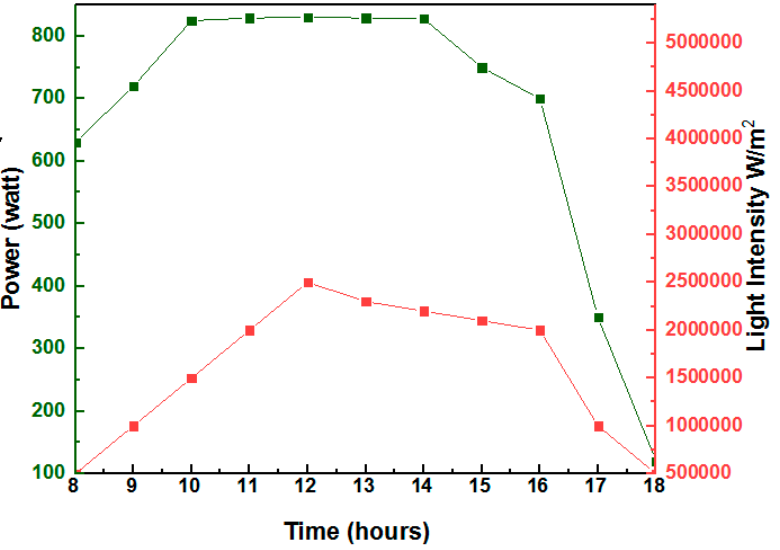
Figure 7. Micro-CPV performance system result of power versus light intensity.